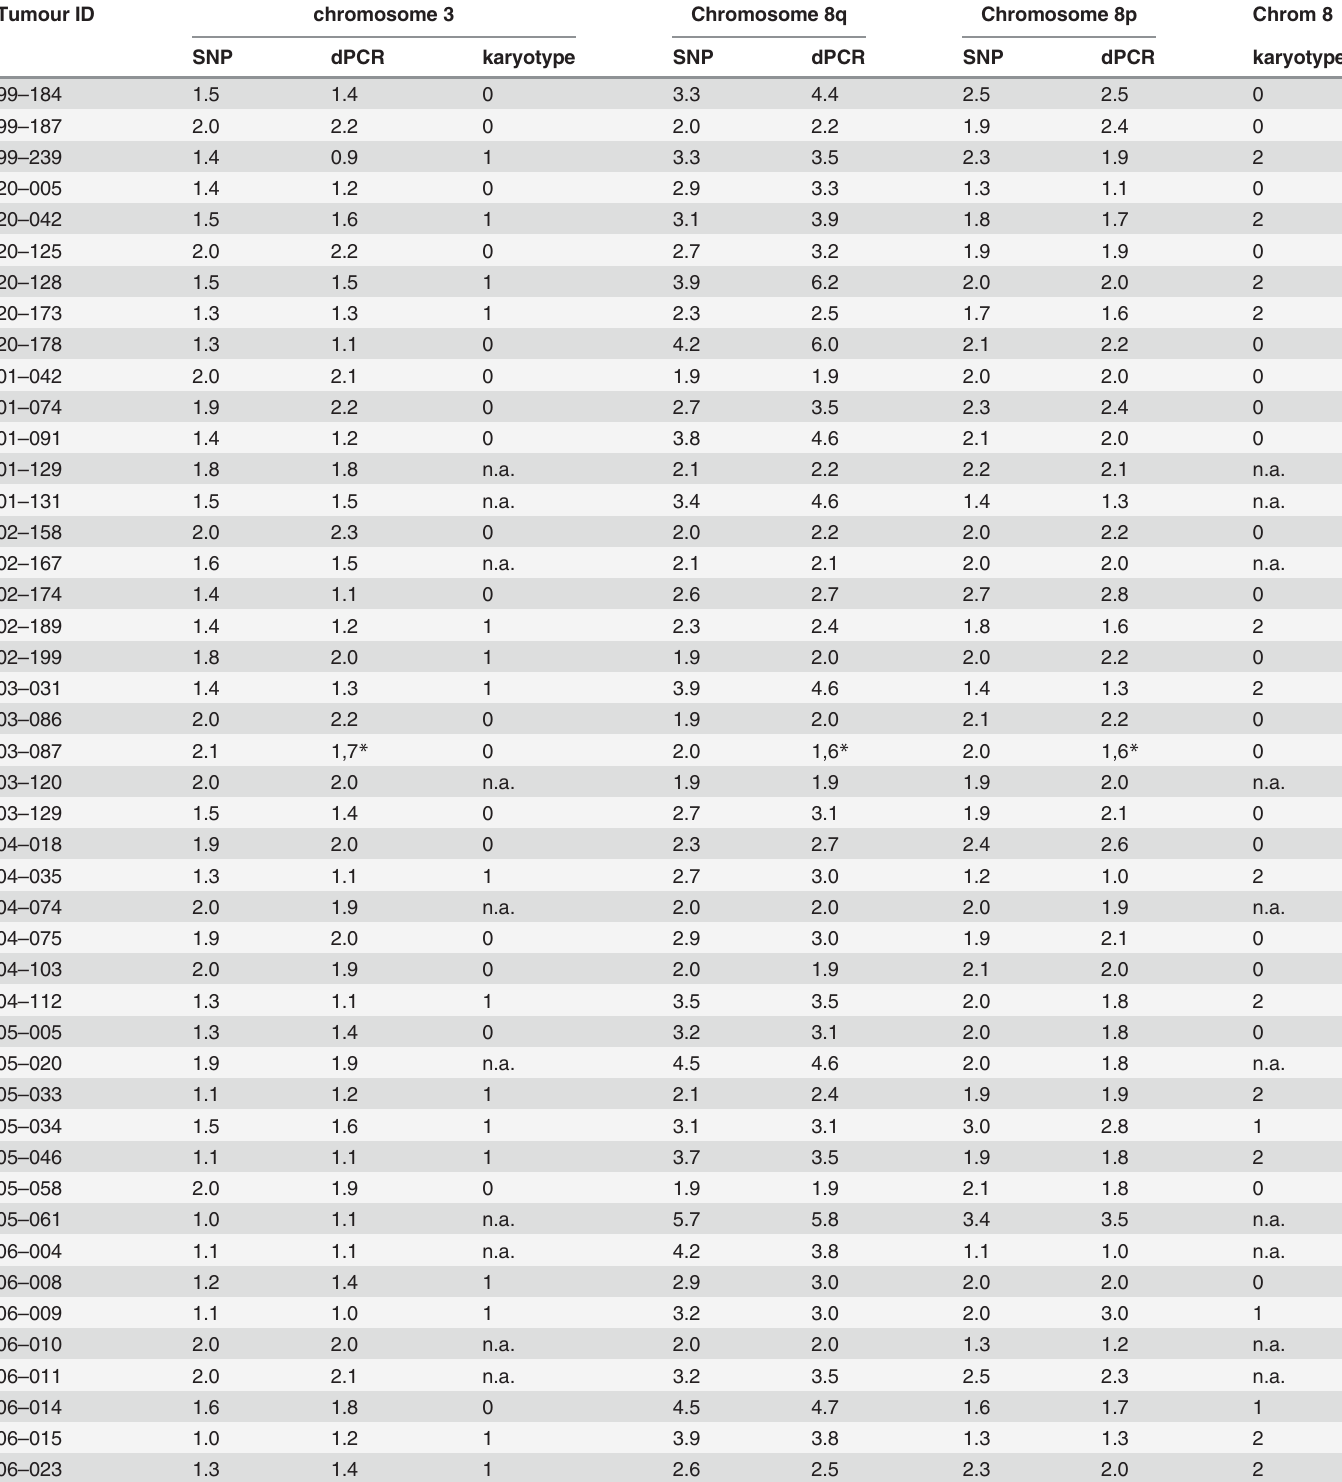
Table 3. Monosomy 3 and chromosome 8 copy number variation: SNP array versus dPCR